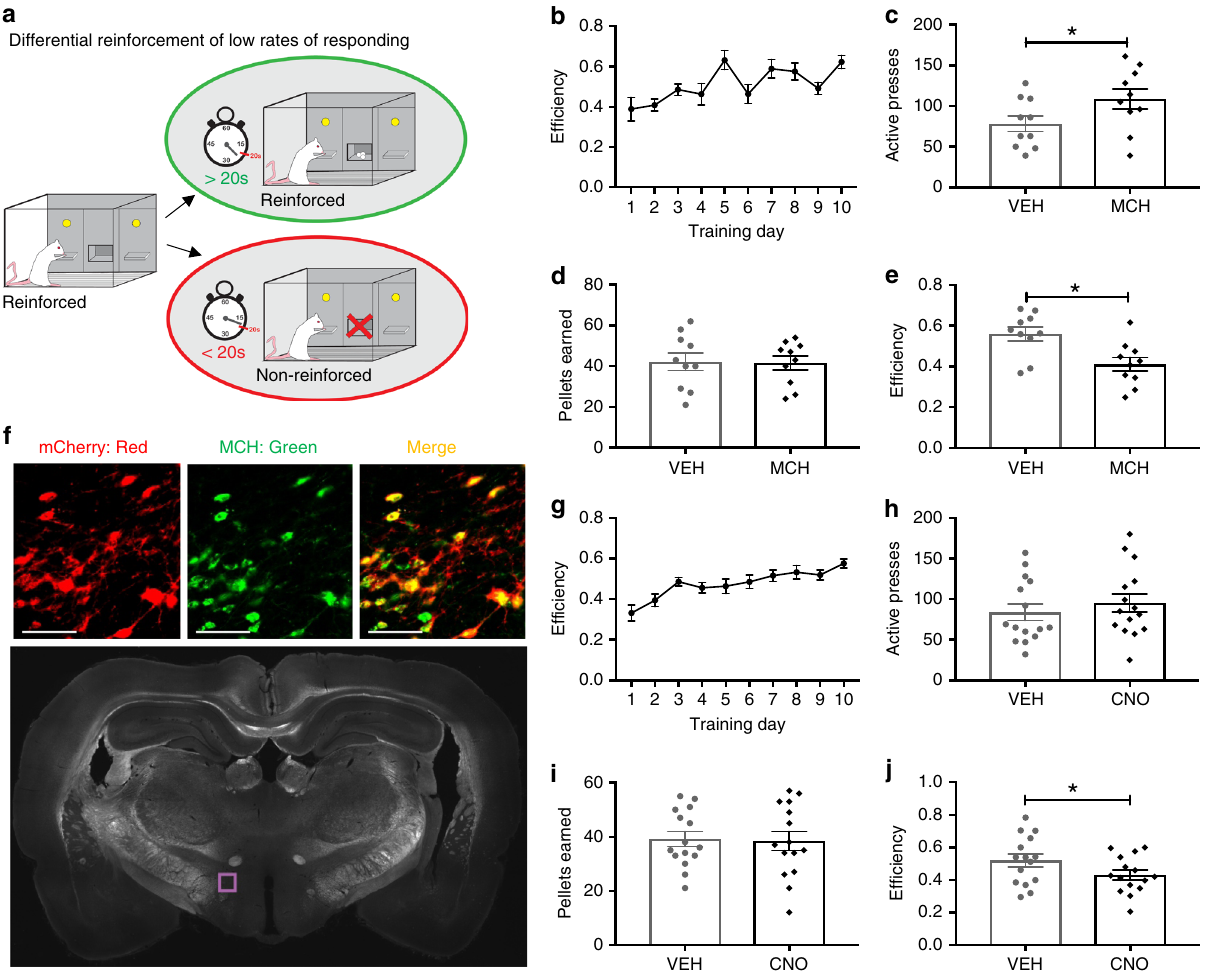
Fig. 1 MCH signaling increases impulsive responding for food. a A schematic diagram of the differential reinforcement of low rates of responding task (DRL). b – e Intracerebroventricular (ICV) injection of MCH (5 µ g) effects on food impulsivity in the DRL task: b ef fi ciency data during the training